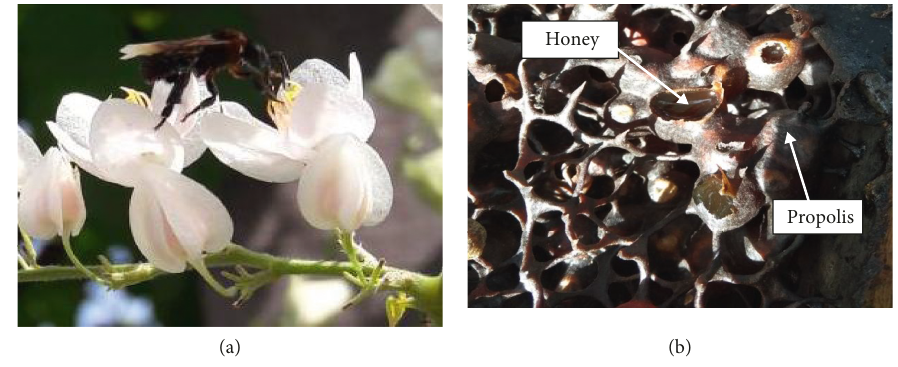
Figure 1: (a) Stingless bee. (b) Stingless bee honey in the